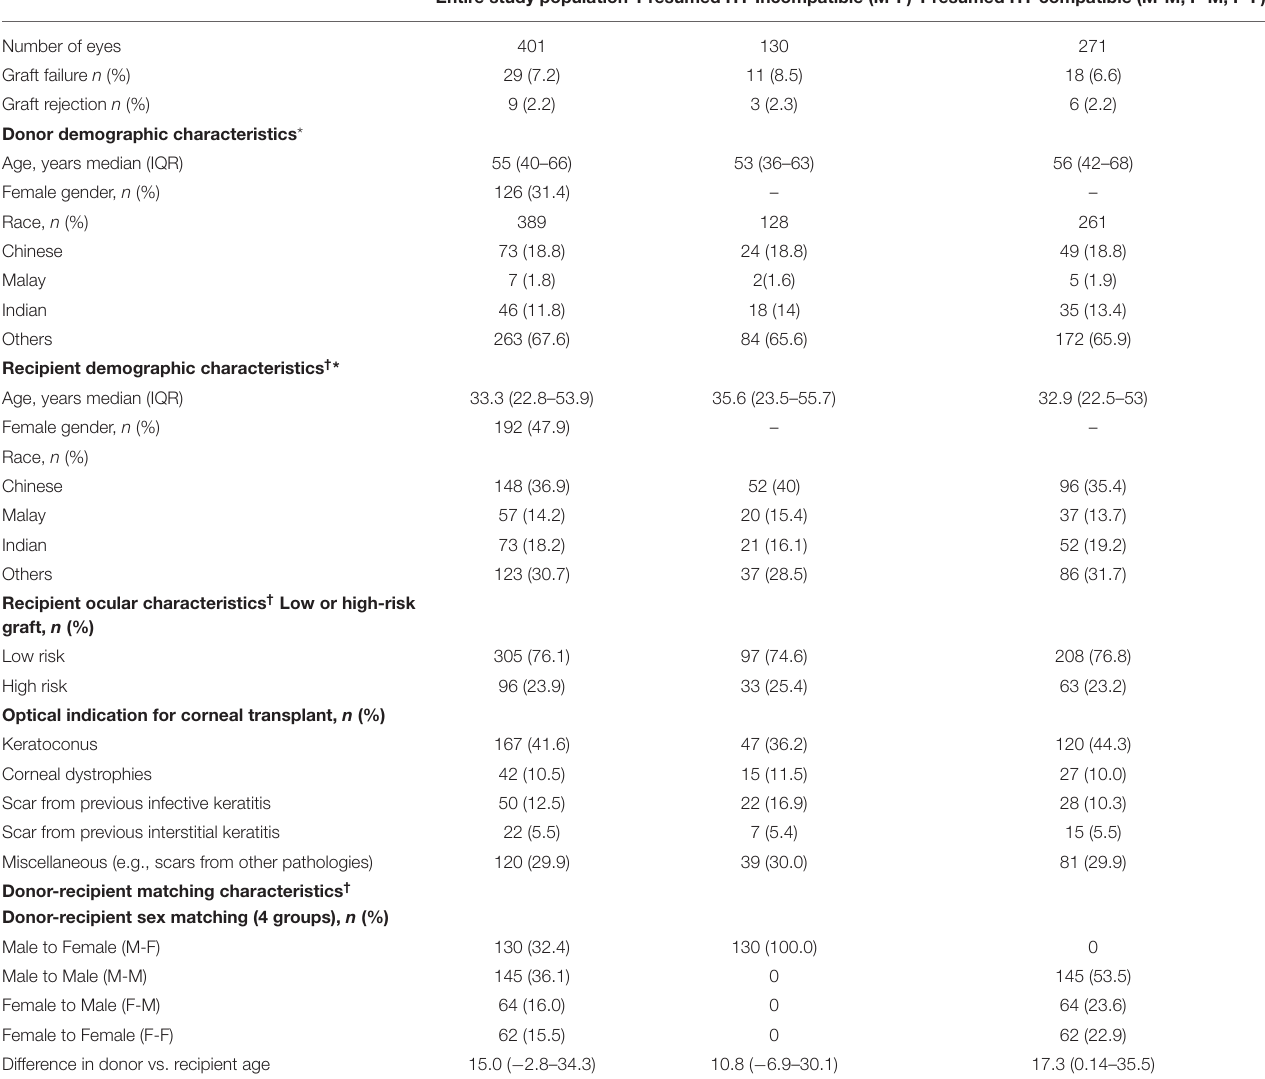
TABLE 1 | Descriptive data of both donors and